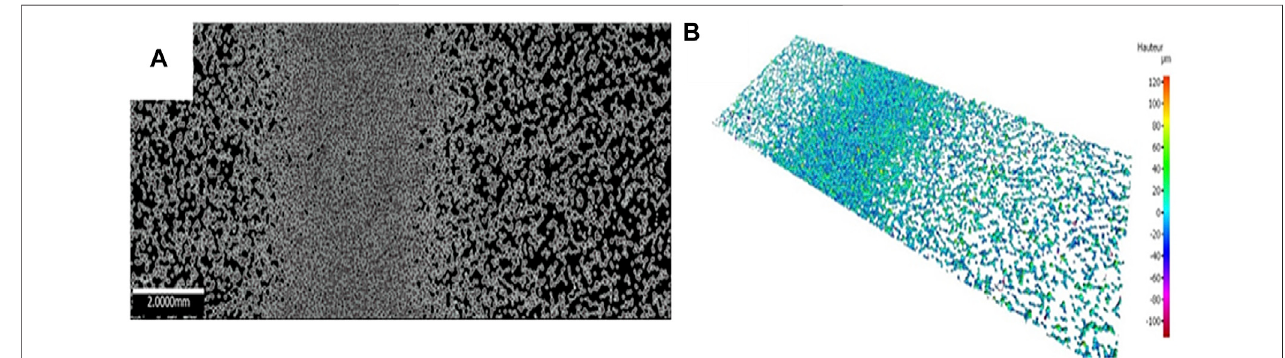
FIGURE 8 | Experimental powder deposited on steel plate with